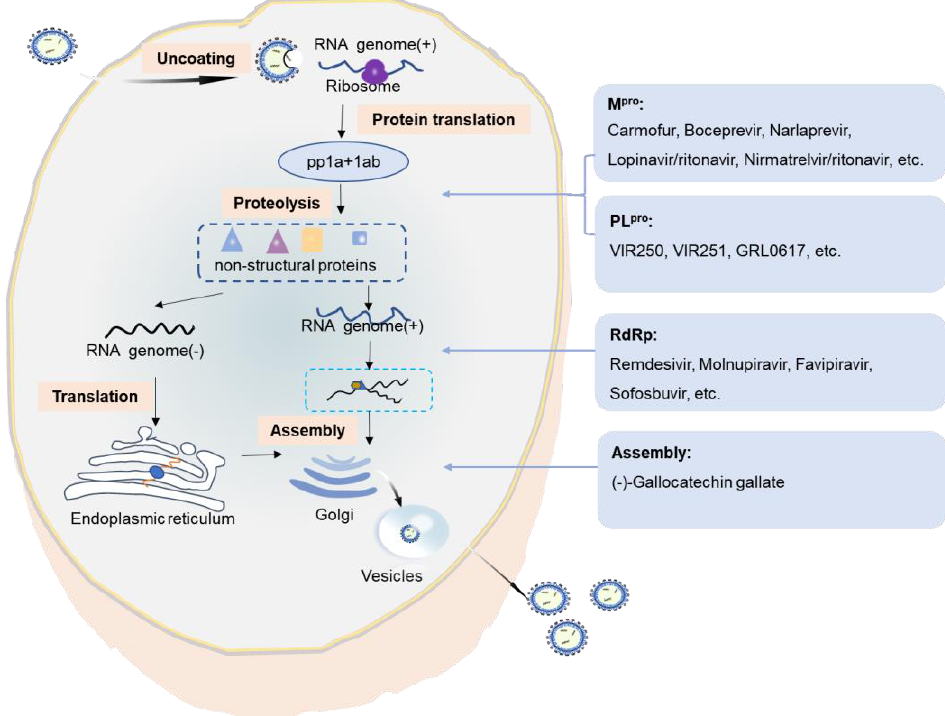
Figure 4. Replication of SARS-CoV-2 in host cells. M pro : main protease; pp1a: polyprotein 1a; pp1ab: polyprotein 1ab; PL pro : papain-like proteinase; RNA: ribonucleic acid; RdRp: RNA-dependent RNA polymerase.